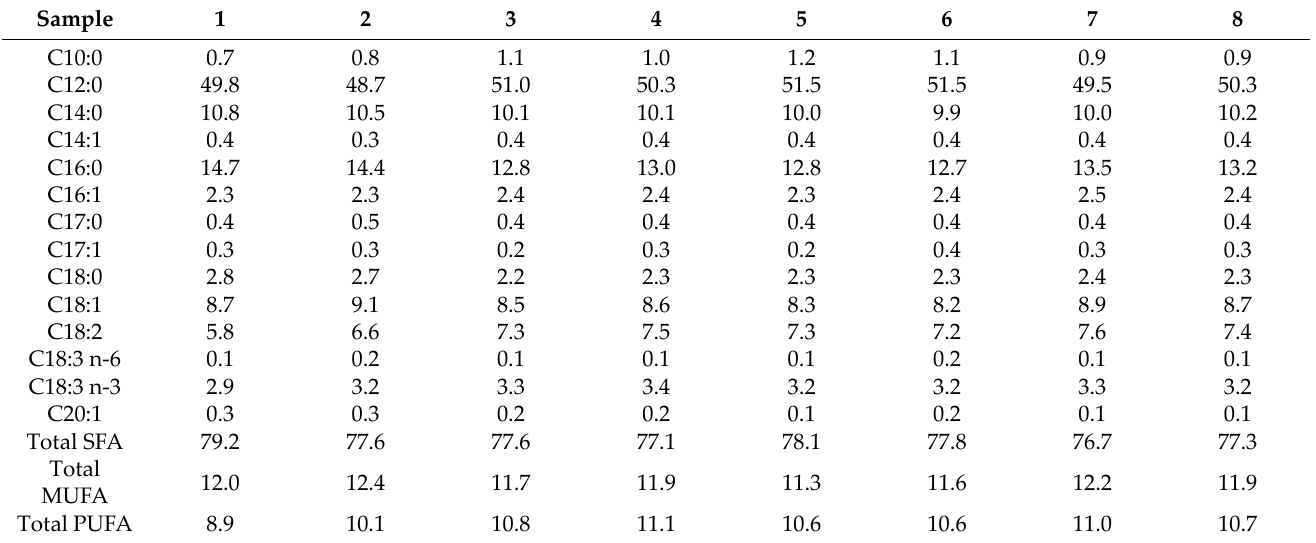
Table 3. Fatty acid profile and total content of saturated fatty acids (SFA), monounsaturated fatty acids (MUFA) and polyunsaturated fatty acids (PUFA) (% w/w) in the oils extracted from the different H. illucens larvae